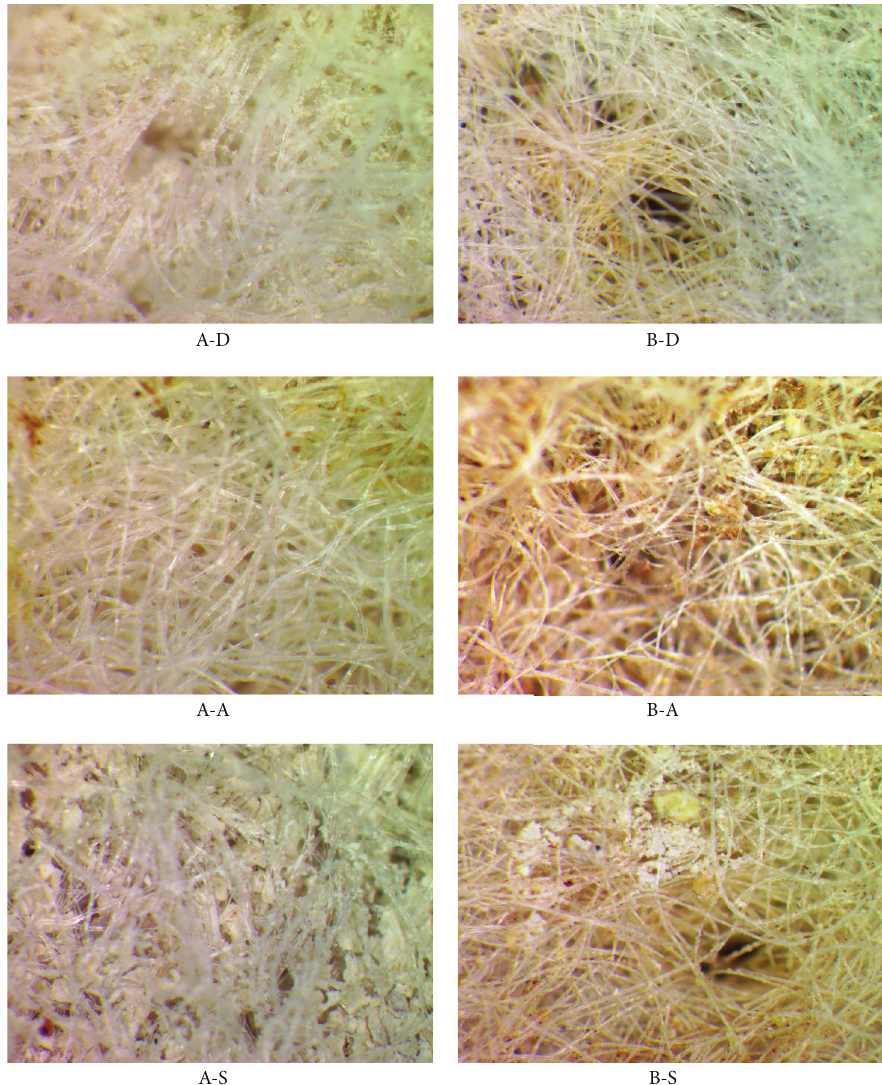
Figure 1: Microscopic view of the physical appearance of the GCL samples: A-D and B-D: initial condition of the GCL; A-A and B-A: GCLs after hydration using distilled water; A-S and B-S: GCLs after hydration using the NaCl